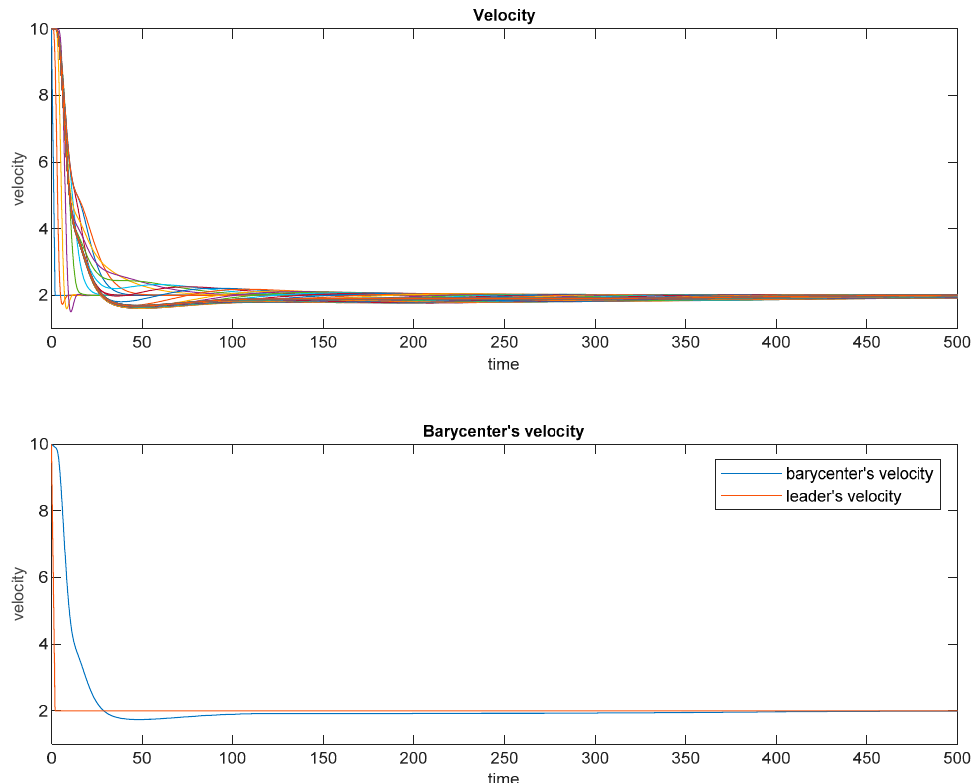
Figure 15. The small-world model simulated with b = 20 m and excited by the harmonic perturbation of the Leader’s velocity Equation (14); symbolism is the same in Figure 11.